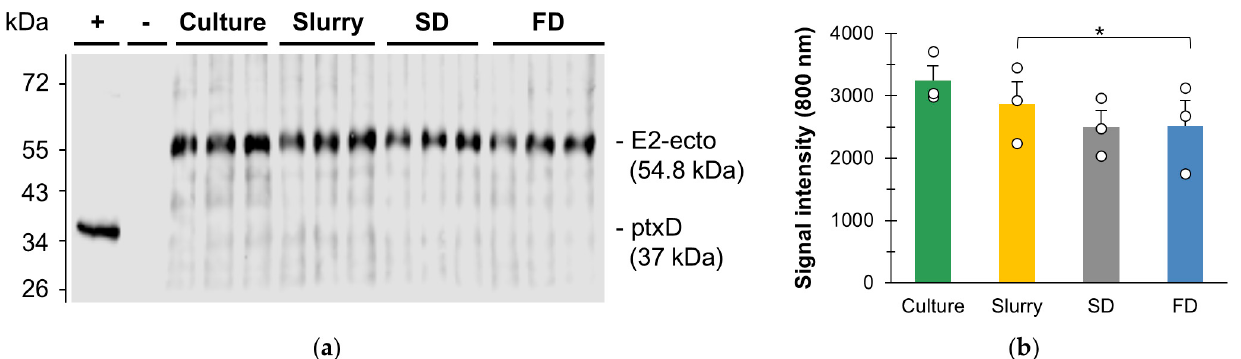
Figure 3. Evaluation of E2-ecto vaccine integrity throughout the manufacturing process, with a focus on the effects of spray drying as compared to freeze drying. ( a ) Immunoblot analysis of E2-ecto vaccine in TN72:E2-ecto cells after cultivation (“culture”, biological triplicates), centrifugation (“slurry”, technical triplicates), spray drying (“SD”, technical triplicates) or freeze drying (“FD”, technical triplicates). Samples were normalized at 30 µg of biomass loaded per well. Positive control (+): TN72:ptxD, negative control (–): TN72:pSRSapI. ( b ) Densitometry analysis of the culture (biological triplicates), slurry, spray-dried (SD) and freeze-dried (FD) samples (technical triplicates) in the 800 nm channel. Data are expressed as the average signal intensity ± one standard error. Individual data points are shown as white circles. Student’s t-tests were applied, with statistically significant differences identified with * ( p -value < 0.05).